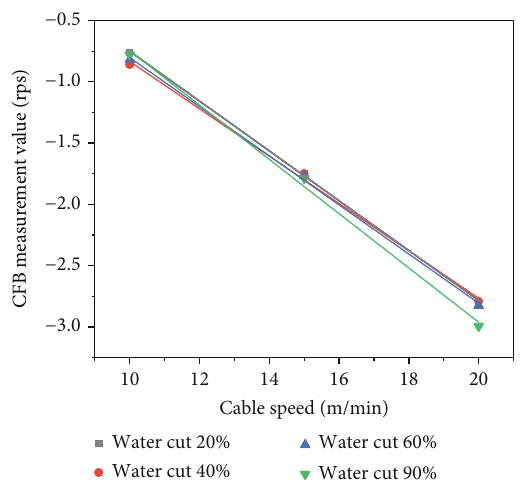
Figure 8: Relational graph of the measured value of 93 ° inclination of 300 m 3 /d CFB and cable speed.